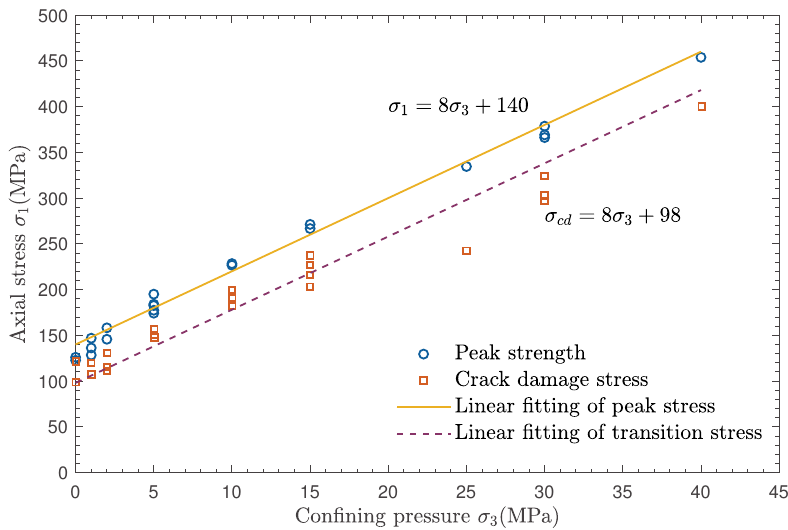
Figure 5. Linear fitting of the peak strength and transition stress extracted from triaxial compression tests on Beishan granite under different confining pressures.